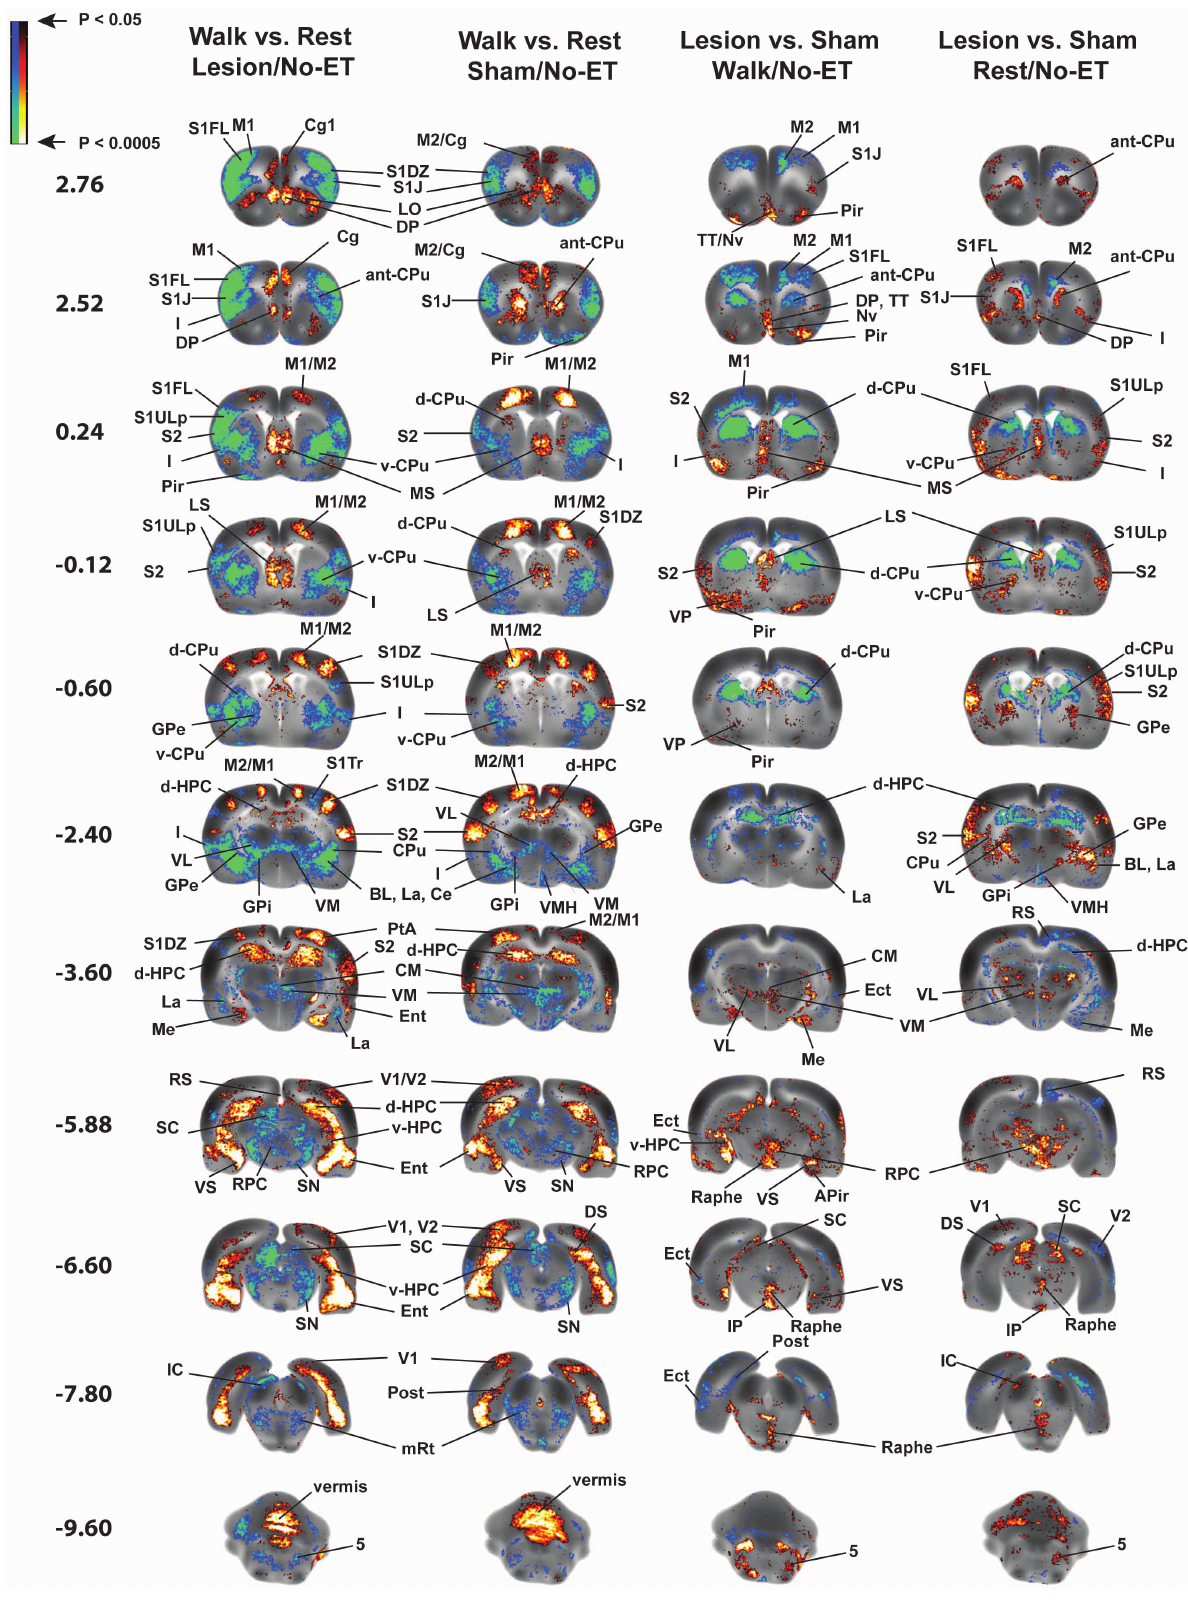
Figure 5. Functional brain activation in rats with bilateral striatal lesions and sham-lesioned rats. Shown are statistically significant differences in activation during acute treadmill walking (Lesion/Walk/No-ET, n =9, Sham/Walk/No-ET, n =10) or at rest (Lesion/Rest/No-ET, n =10, Sham/Rest/No-ET, n =9). Comparison highlights lesion effects (Lesion vs. Sham) or the effect of walking (Walk vs. Rest). No exercise training (ET) was